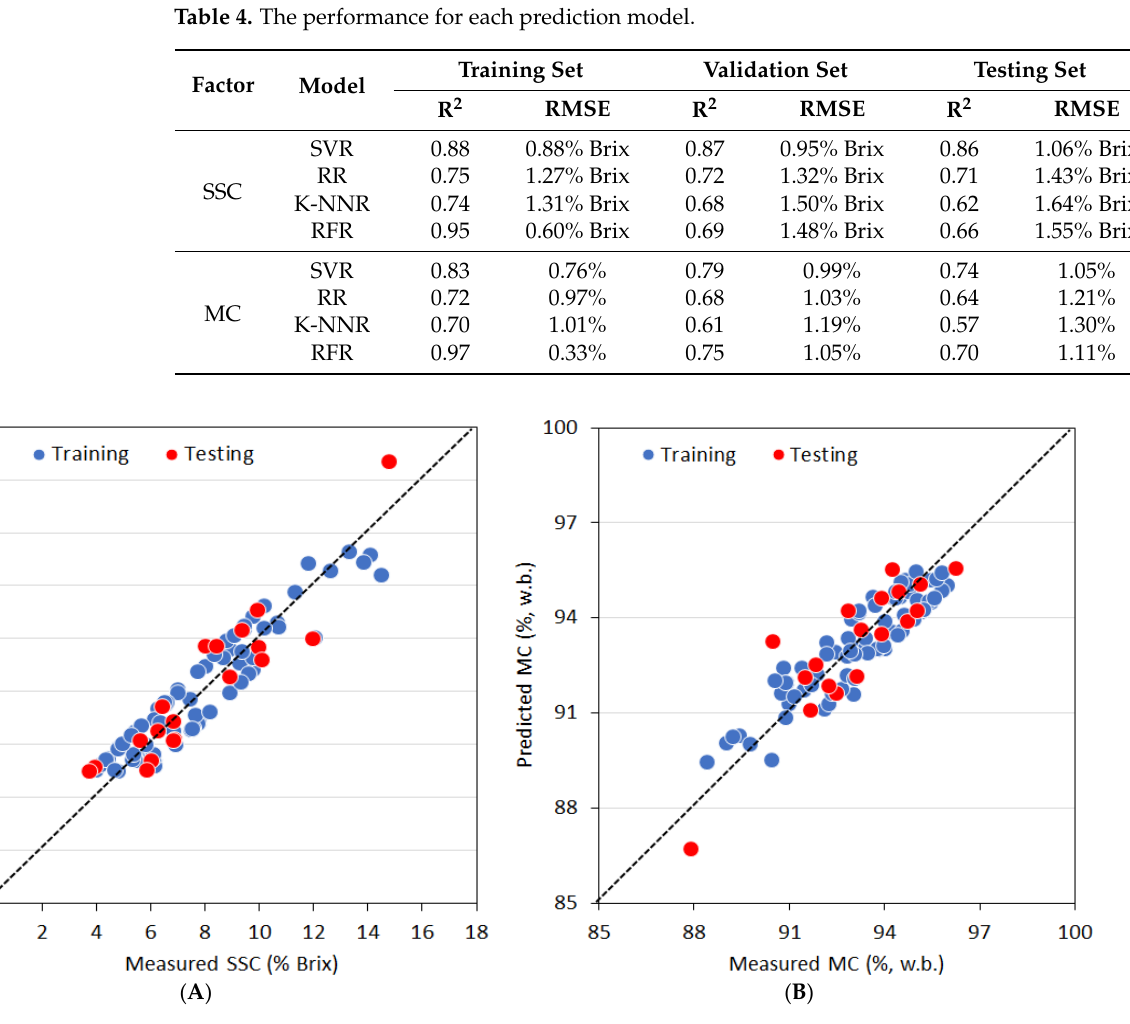
Figure 7. Match between measured and predicted values for ( A ) SSC and ( B ) MC obtained from the best prediction models.